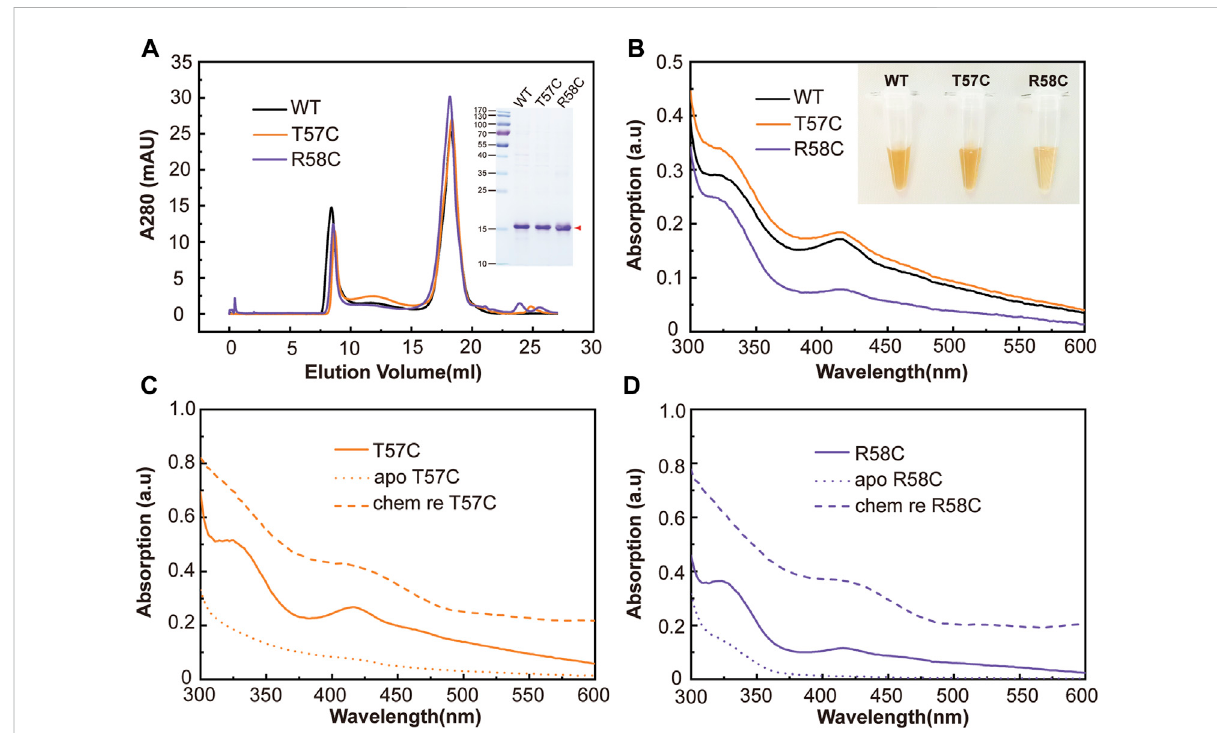
FIGURE 3 Mutations designed around C60 region in clMagR identi fi ed T57C increased iron-sulfur cluster binding. (A) Size-exclusion chromatography of puri fi edwildtypeclMagR(WT,blackline)anditsmutants,clMagR T57C (abbreviatedasT57C,orangeline)andclMagR R58C (abbreviatedasR58C,purple line). SDS-PAGEs of protein preparation are shown as inserts. (B) UV – Vis absorption spectrum of puri fi ed clMagR (WT) and its mutants (T57C and R58C),withthesamecolorschemeasin (A)(C,D) UV-VisabsorptionspectrumofchemicallyreconstitutedclMagRmutants,T57C (C) andR58C (D) . The data for chemically reconstituted wild type clMagR protein was shown in Figure 2D. As-isolated proteins were shown as solid lines, apo proteins with iron-sulfur cluster removal were shown as dotted lines, and chemically reconstituted proteins (labeled as chem re) were shown